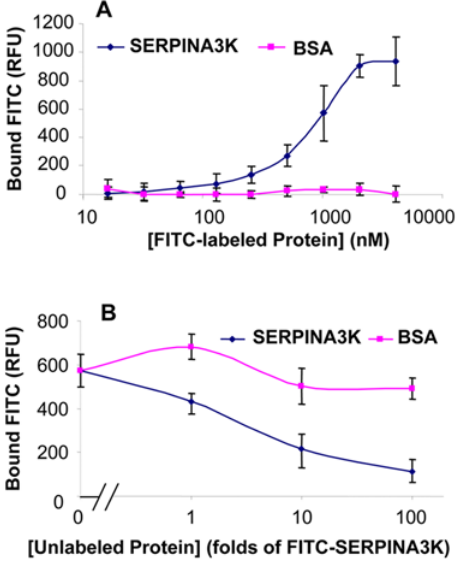
Figure 7. SERPINA3K binds to Mu¨ller-derived rMC-1 cells. ( A ) The rMC-1 cells were incubated with increasing concentrations of FITC- SERPINA3K or FITC-BSA for 1 h. ( B ) The rMC-1 cells were incubated with 400 nM FITC-SERPINA3K in the presence of different concentrations of unlabeled SERPINA3K or BSA for 1 h. Then the cells were washed three times with PBS. The fluorescence in the cells was measured by a fluorometer using 485/530 nm filter (mean 6 SEM, n=8).